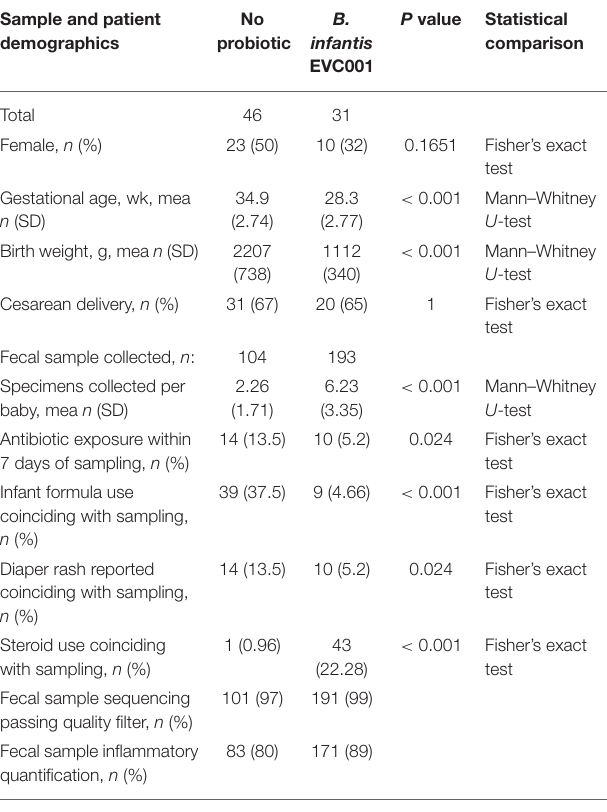
TABLE 1 | Characteristics of preterm infant feeding cohort and sample